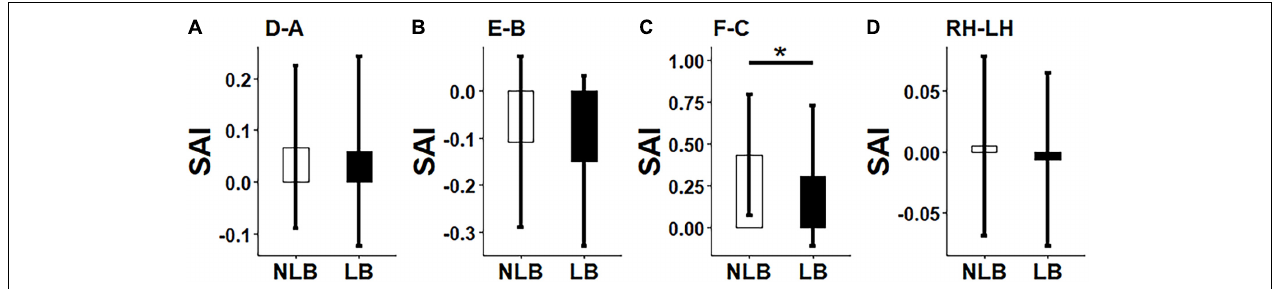
FIGURE 4 | Differences between left-behind and non-left-behind children in synchronization asymmetry of (A) : Region-pair D-A; (B) Region-pair E-B, (C) Region-pair F-C, and (D) Hemisphere-pair RH-LH. NLB, non-left-behind; LB, left-behind, * p <